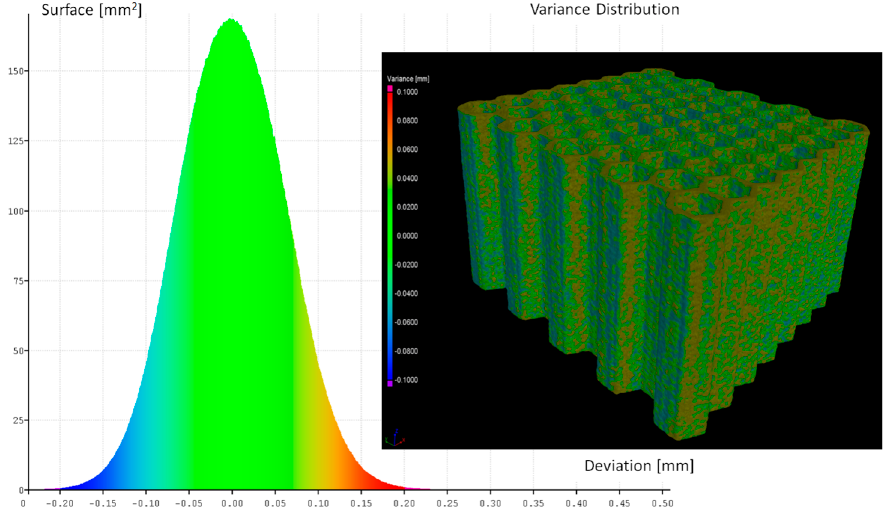
Figure 7. Geometrical quality control of specimen No. 2 before versus after heat treatment.